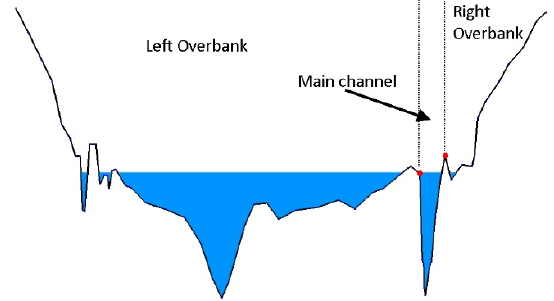
Figure 1. The three subsections of a typical natural section.